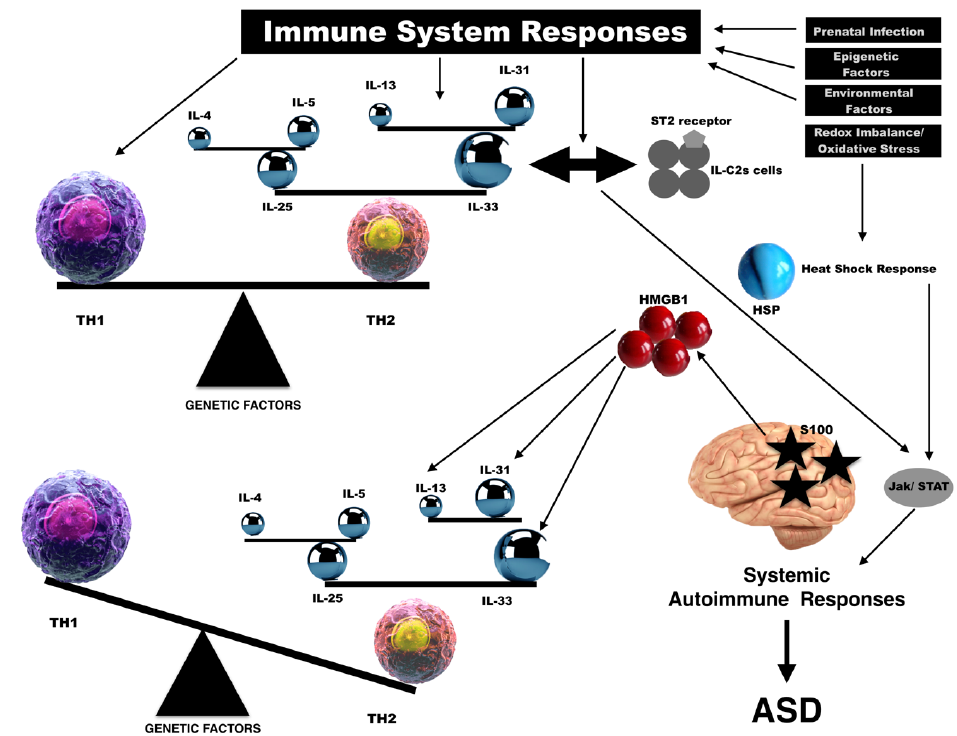
Figure 1. Alarmins involvement in the immune system balance in relation to autism spectrum disorders (ASDs). IL: interleukin; TH: T helper 1/2 immune response; ST2: suppressor of tumorigenicity 2; IL-C: Innate lymphoid cells; HSP: Heat shock protein; HMGB1: High mobility group box-1; Jak/STAT: Janus kinase/Signal Transducer and Activator of Transcription protein.